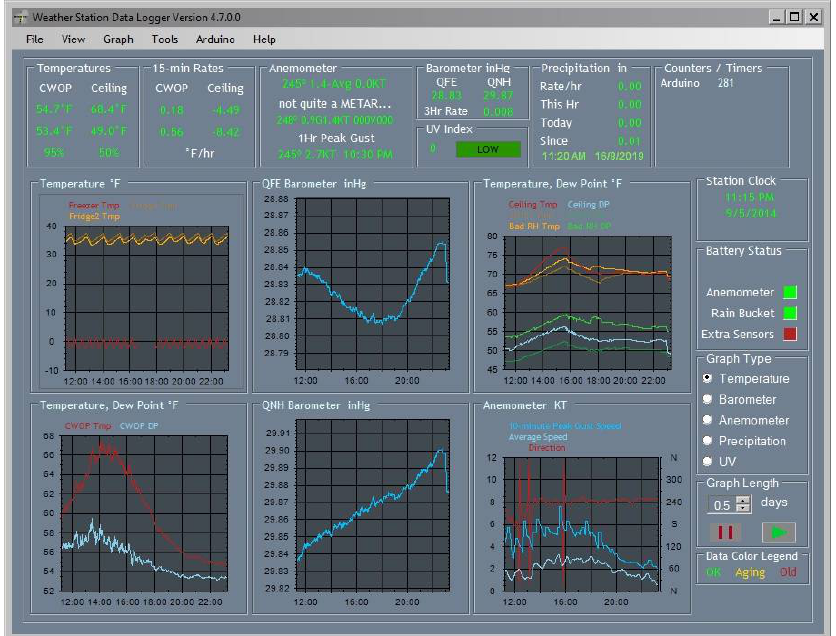
Figure 22. Environmental samples taken with an Arduino-controlled weather station p / n 80,422. The values recorded by the weather station correspond to a summer period.